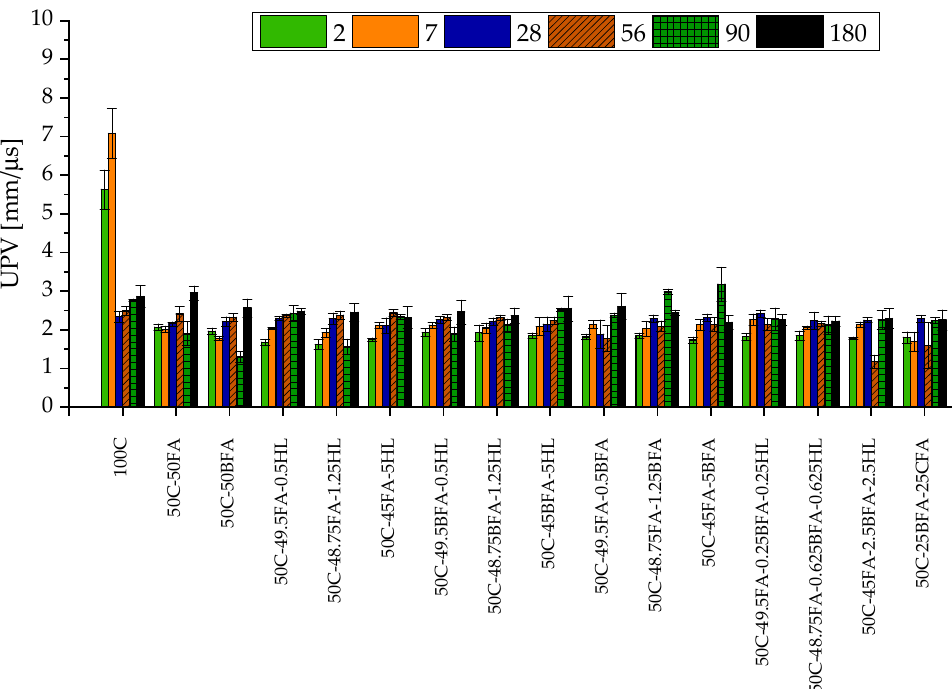
Figure 3. UPV values from the semi-direct method for the different mortar formulations for 2, 7, 28, 56, 90, and 180 of curing.